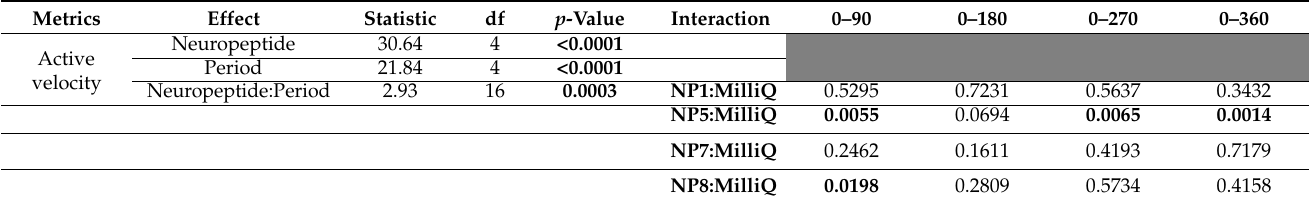
Table 3. Two-way ART ANOVA results, comparing the effects of S. mansoni cercarial exposure to NP1, NP5, NP7, and NP8 at 3 mg/mL to MilliQ water pre-exposure and at 90 min intervals over 360 min post-exposure (final concentration: 59 µ g/mL). Test statistics, degrees of freedom, and p -values for the main effects of putative neuropeptide and period (pre-exposure vs. 90 min, 180 min, 270 min, and 360 min post-exposure), and their interaction. If the interaction effect was significant,